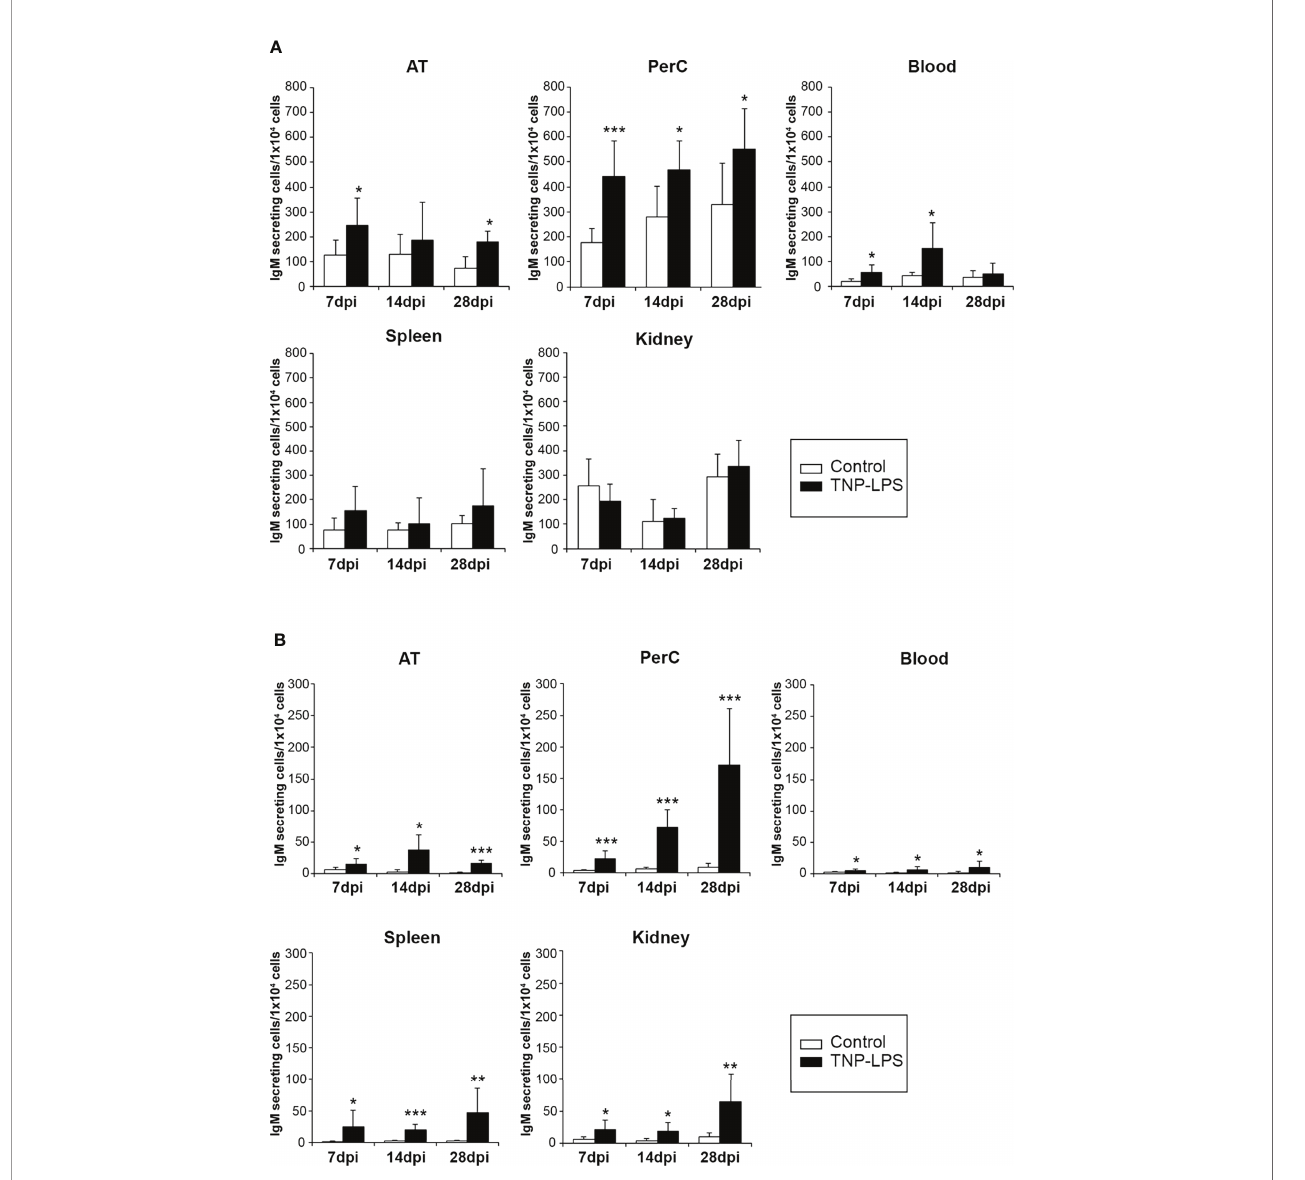
FIGURE 5 | Quanti fi cation of total and TNP-speci fi c IgM-secreting cells after the intraperitoneal immunization of rainbow trout with TNP-LPS. (A) The amount of total IgM-secreting cells in AT, peritoneal cavity (PerC), blood, spleen and head kidney (HK) was established by ELISPOT as described in the Materials and Methods section. Results are shown as mean number of IgM-secreting cells per 1 x 10 4 total leukocytes + SD (n = 8). Asterisks denote signi fi cantly different values between groups as indicated (*p ≤ 0.05 and ***p ≤ 0.005). (B) To determine the amount of cells secreting TNP-speci fi c IgMs, ELISPOT plates were coated with TNP-BSA and developed using a biotinylated anti-trout IgM mAb. Results are shown as mean number of IgM-secreting cells per 1 x 10 4 cells + SD (n = 8). Asterisks denote signi fi cantly different values among groups as indicated (*p ≤ 0.05 **p ≤ 0.01 and ***p ≤